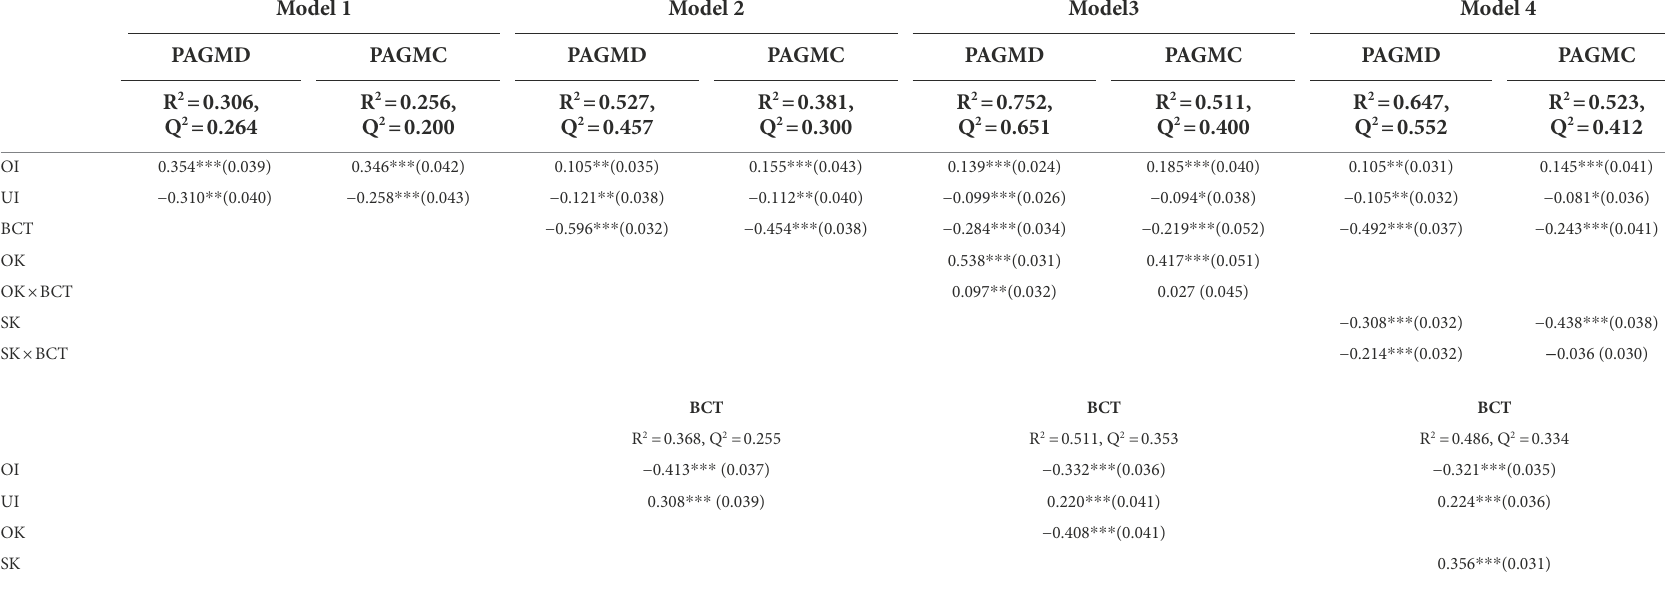
TABLE 6 Path coefficients of the structural